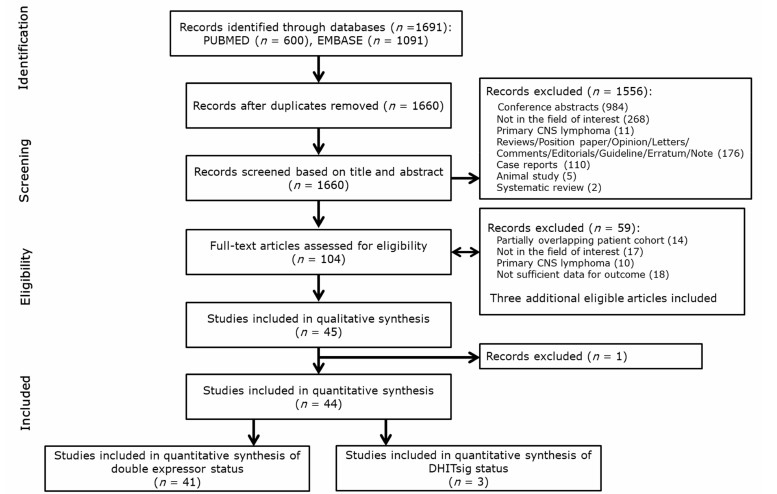
Figure 1. Flow diagram showing study selection process for systematic